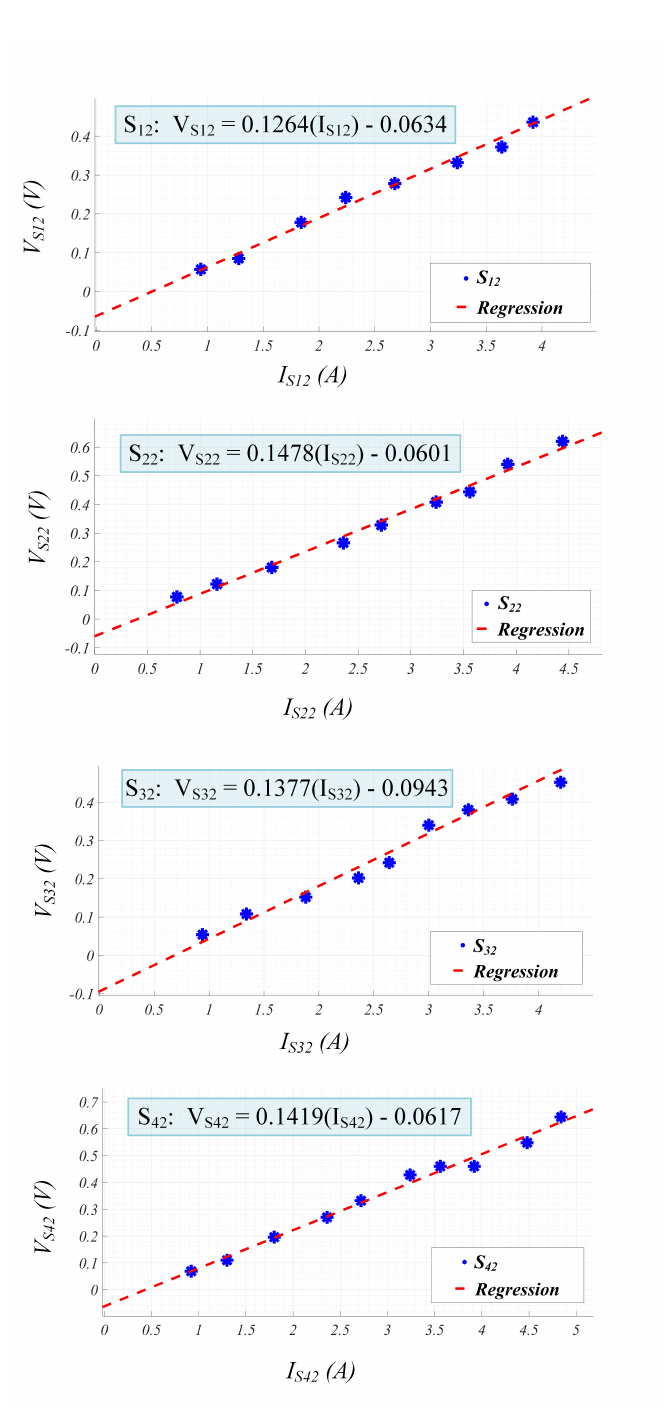
Figure 11. Individual calibration of S 12 , S 22 , S 32 , and S 42 sensors in the sensor